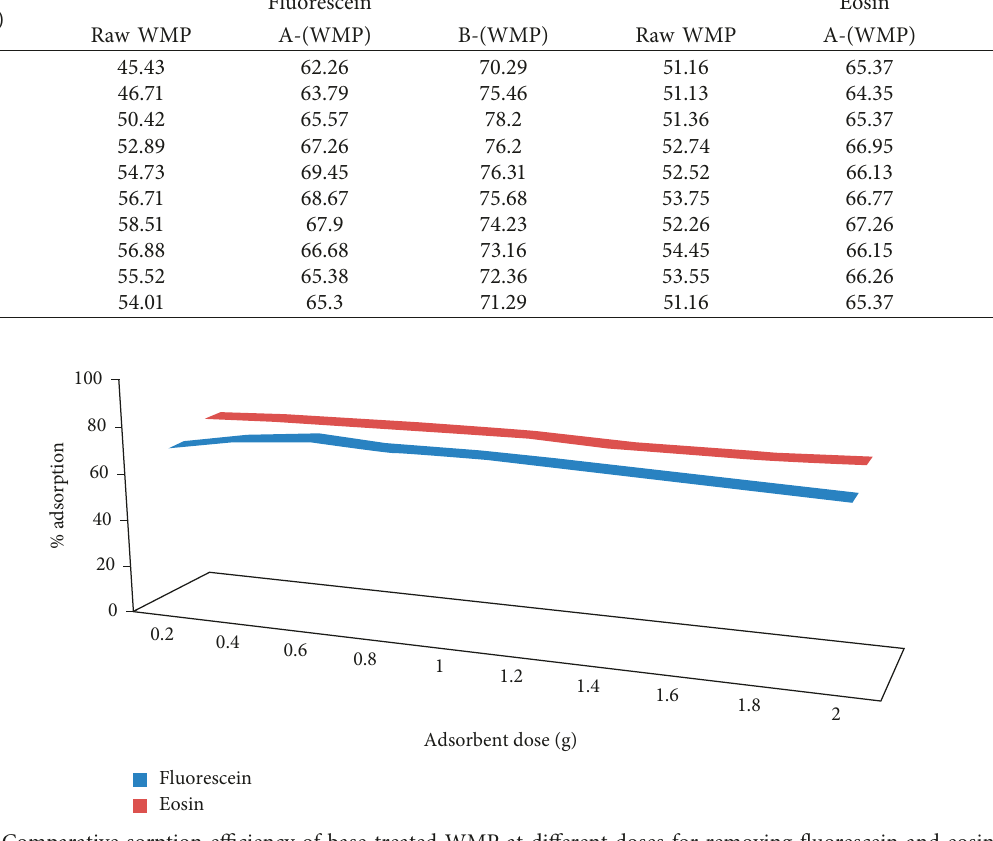
Table 2: Sorption efficiency of WMP sorbent at different doses. Sorbent dose (g)